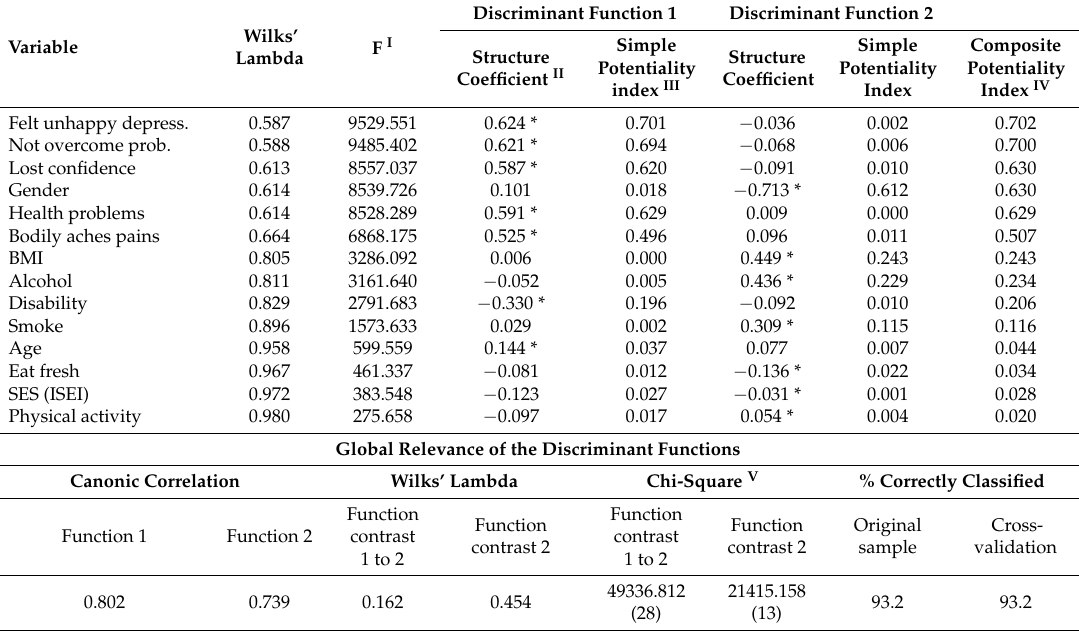
Table 4. Discriminant analysis for validation of clustering technique and study of variables global